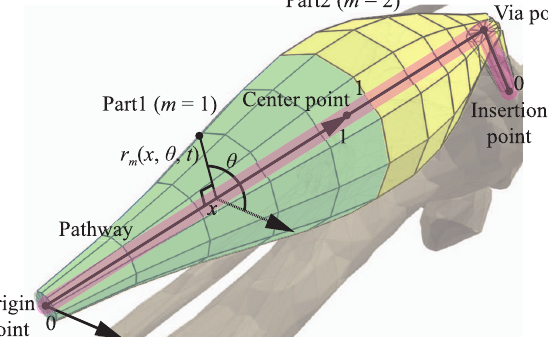
Fig. 3 Muscle shape and its local coordinate system. The red line represents the muscle pathway that connects the origin point, one or more via points, and the insertion point. x is the location along the muscle pathway, θ is the angle from the polar axis, and r m is the distance from the